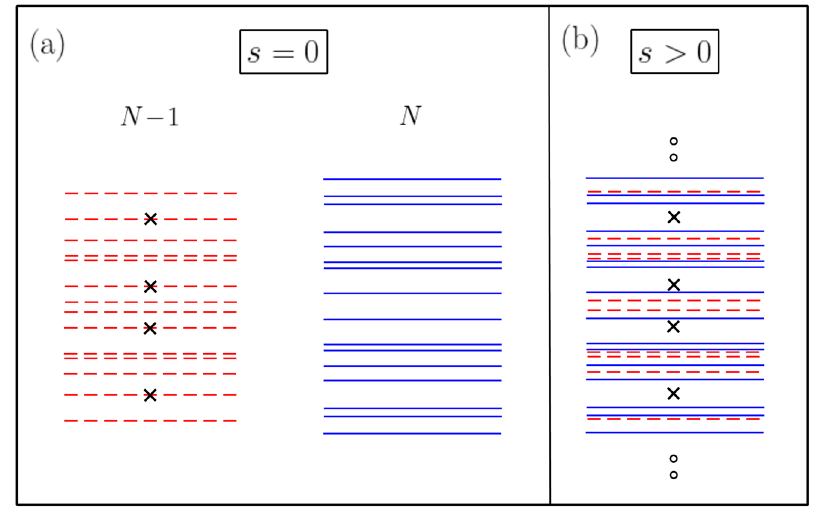
Fig. 2 Schematic representation of the unperturbed and perturbed spectrum for n ≤ 1/2. a The unperturbed band spectrum of ( N − 1) hard-core bosons (red dashed lines) and N hard-core bosons (blue solid lines). The crosses mark those levels which disappear under the perturbation. b The perturbed spectrum consisting of the shifted unperturbed levels (dashed red and solid blue lines) and the crosses mark those levels of the unperturbed ( N − 1)- particle spectrum which has disappeared. The open circles are the new levels generated by the perturbation.